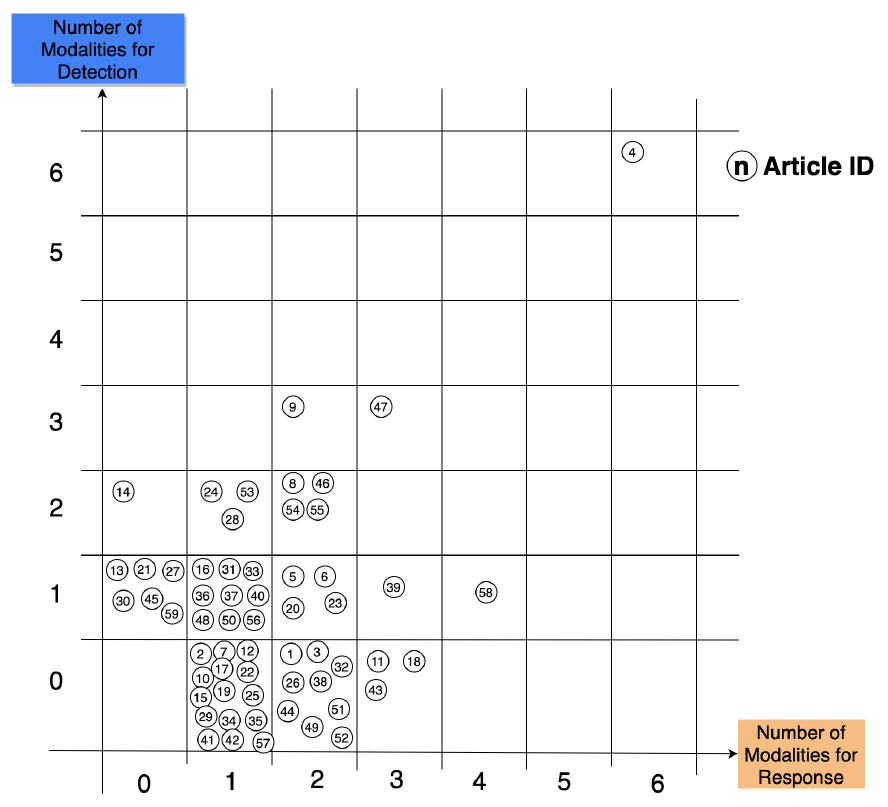
Figure 8. Article representation over detection and response modalities.